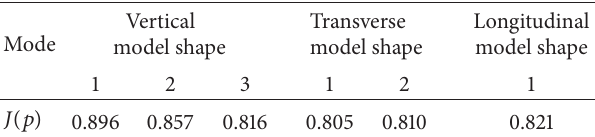
Table 15: Overlap ratio index of each modal frequency without the average absolute value of relative errors.